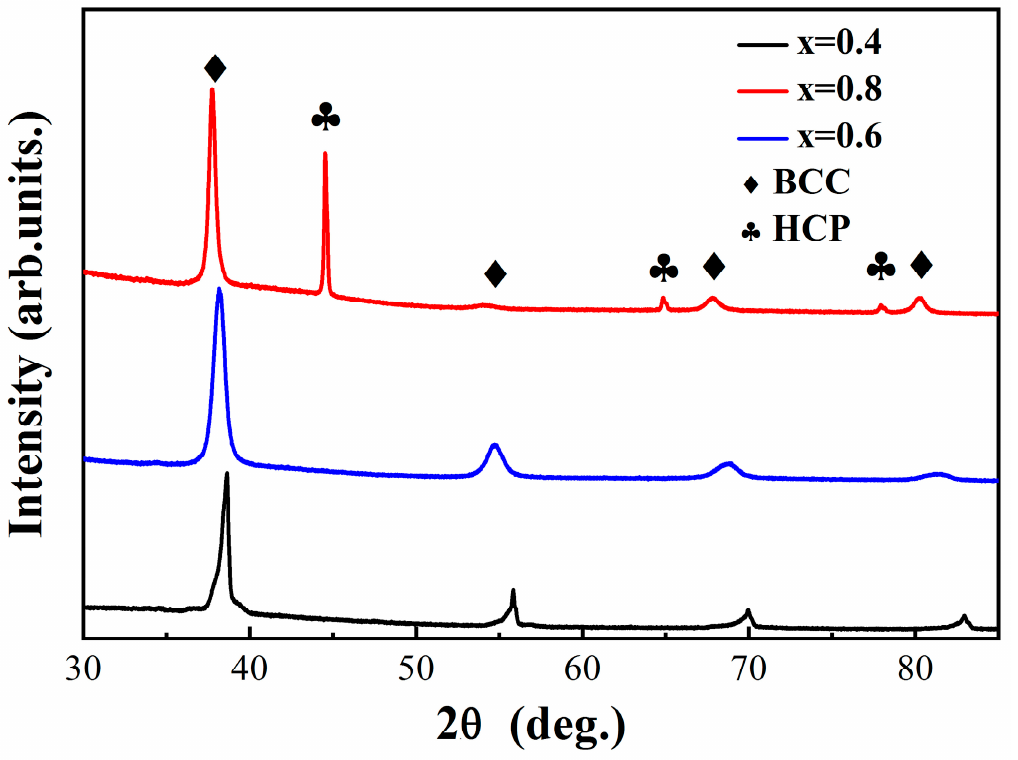
Figure 1. X-ray diffraction patterns of as-solidified HEAs with the compositions of (TiZr) x (NbTaV) 1 − x ( x = 0.4, 0.6, and 0.8).